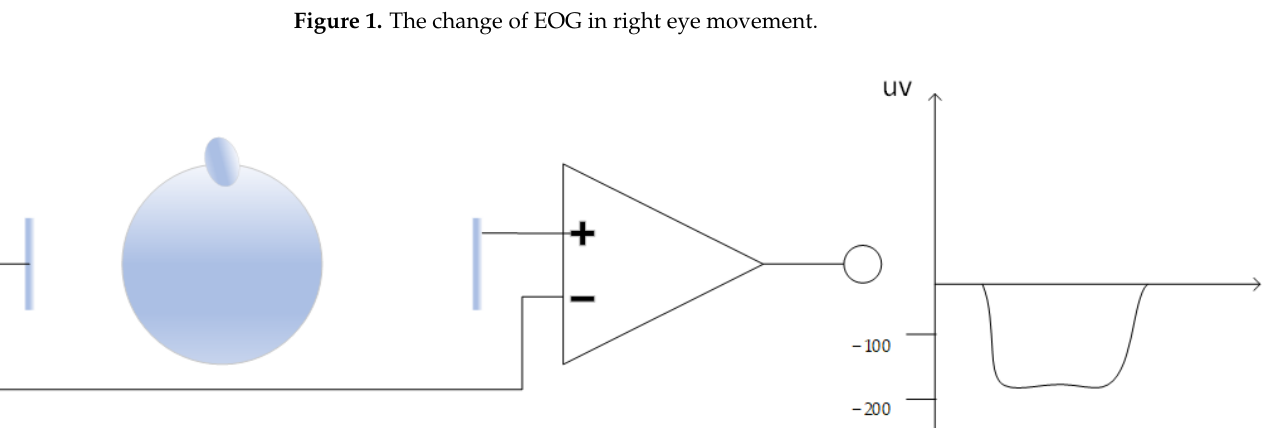
Figure 2. The change of EOG in left eye movement.